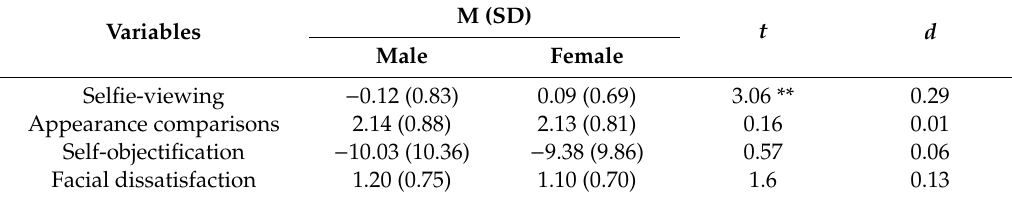
Table 4. Means (SD), and independent samples t -tests comparisons between males and females.